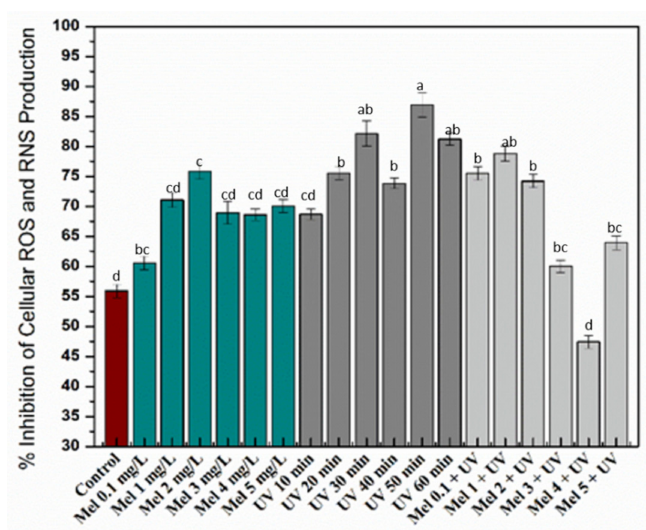
Figure 4. Percentage inhibition of cellular reactive oxygen / nitrogen species (ROS and RNS) production under di ff erent treatments of UV-C, melatonin and Mel + UV-C. Columns with similar alphabets are not significantly di ff erent ( p < 0.05) according to Tukey’s test.